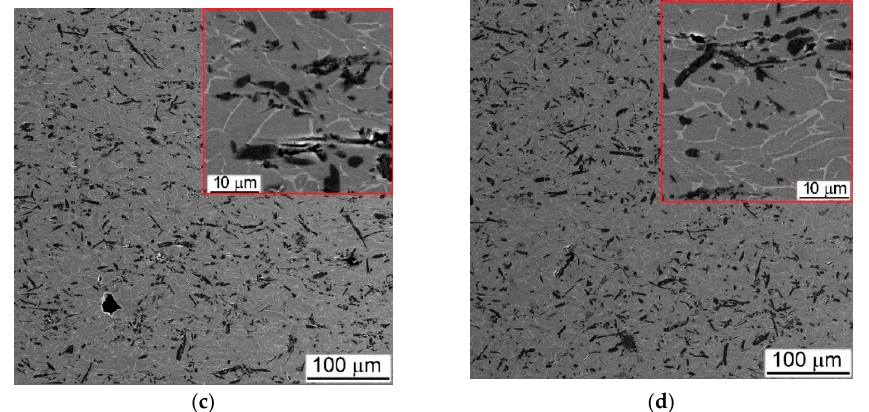
Figure 17. SEM BSE images of Ti64 + 10TiB after the SHPB tests with strain rates ( a , b )—1280 s − 1 , ( c , d )—2510 s − 1 . ( a , c )—Zone II; ( b , d )—Zone I.